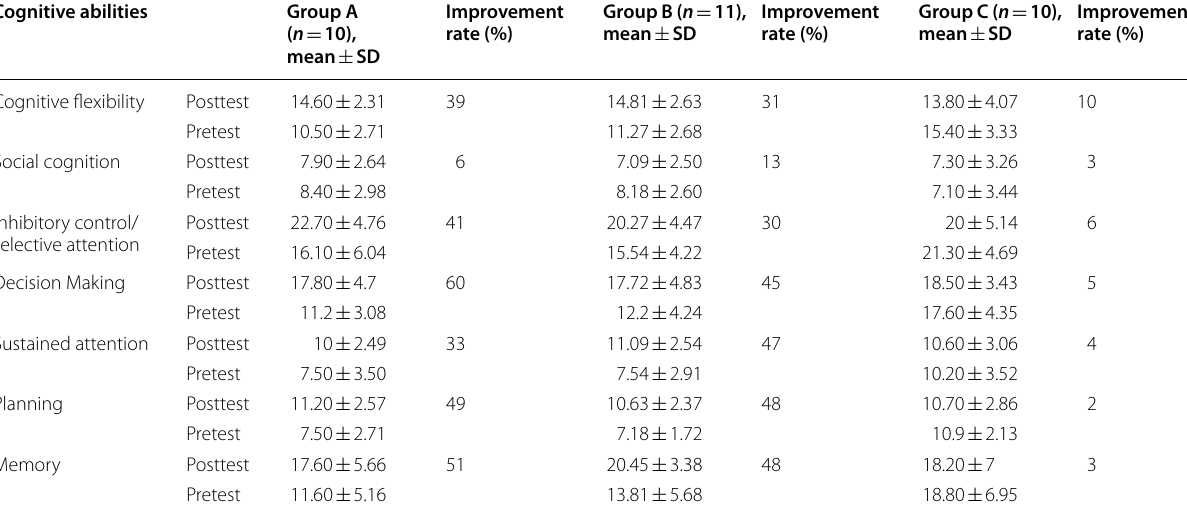
Table 2 Mean and standard deviation (SD) of COQ scores before and after intervention Cognitive